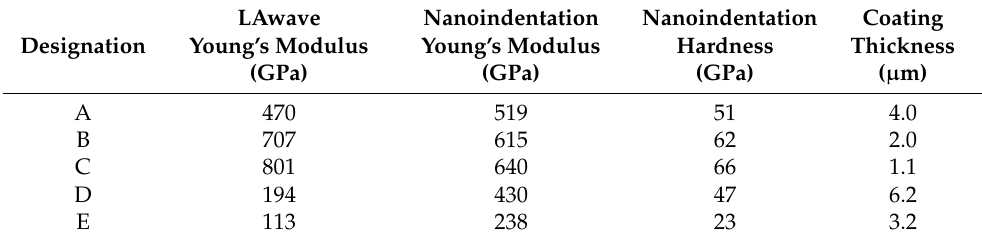
Table 4. Measured coating properties for carbon coatings A–E.